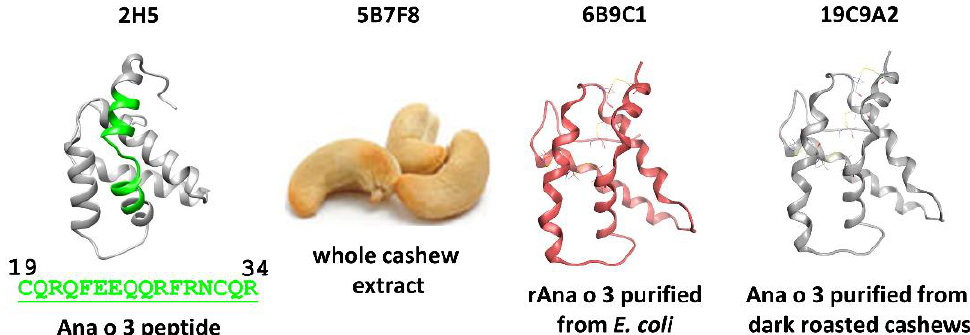
Figure 1. Immunogens used to generate the anti-Ana o 3 monoclonal antibodies included a synthetic Ana o 3.0101 peptide (2H5), whole cashew extract (5B7F8), purified recombinant Ana o 3.0101 produced in E. coli (6B9C1), and native Ana o 3 purified from dark roasted cashew nuts (19C9A2). The 2H5 antibody (isotype IgG2b, K ), which was raised against the Ana o 3 peptide H2N-CQRQFEEQQRFRNCQR − OH and recognizes both the recombinant Ana o 3.0101 and native Ana o 3 proteins, has been described previously